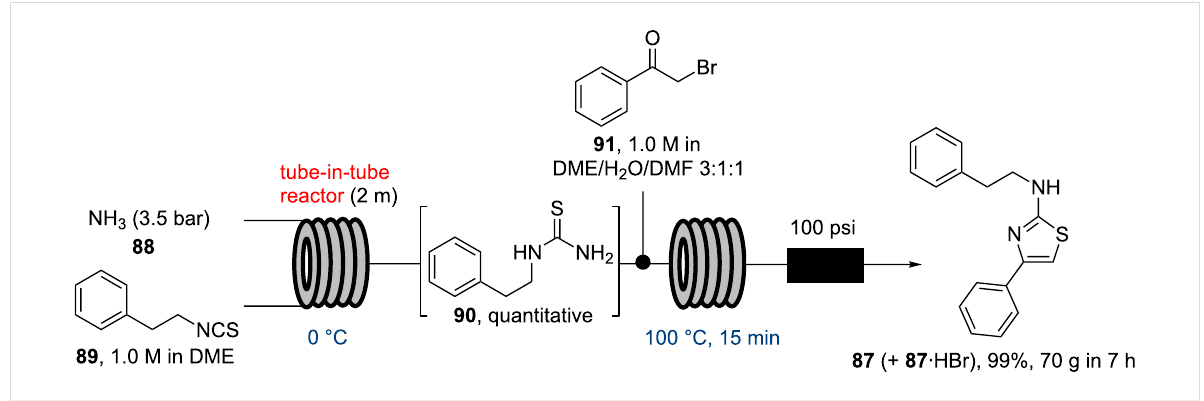
Scheme 15: Flow synthesis of fanetizole ( 87 ) via tube-in-tube system.